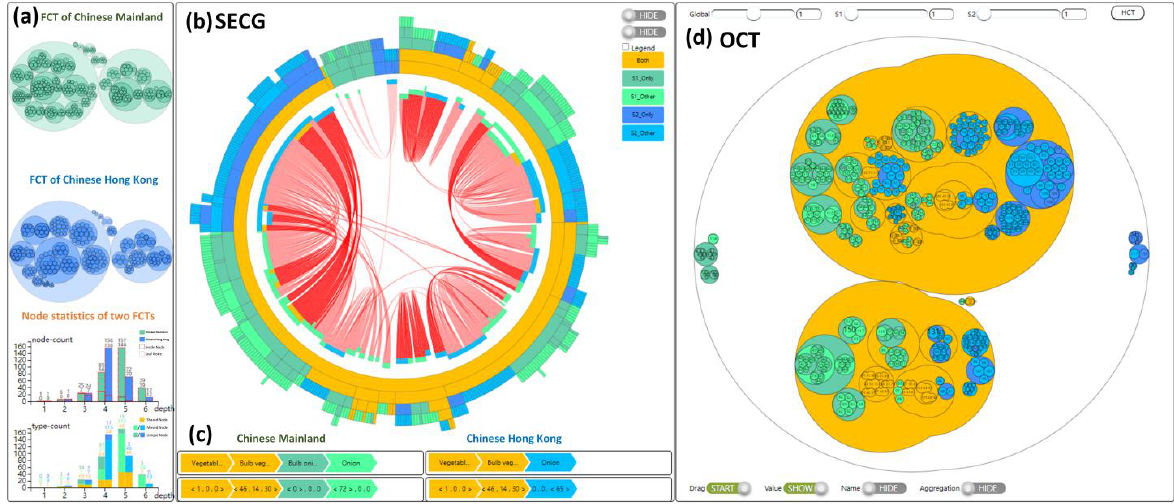
Figure 11. System interface of FCTvis, which is used for comparative analysis of topology and attribute values among FCTs. ( a ) Using the circular treemap to visualize two FCTs and the histogram to describe the node distribution at each level of the two trees and the matching of node labels in the two trees. ( b ) Using SECG to visualize the whole union tree as an overview for users to explore. ( c ) Describing paths and values of the selected node in ( b ). ( d ) Using OCT for details and in-depth exploration of the topology structure and value changes, helping users find the connections between them.